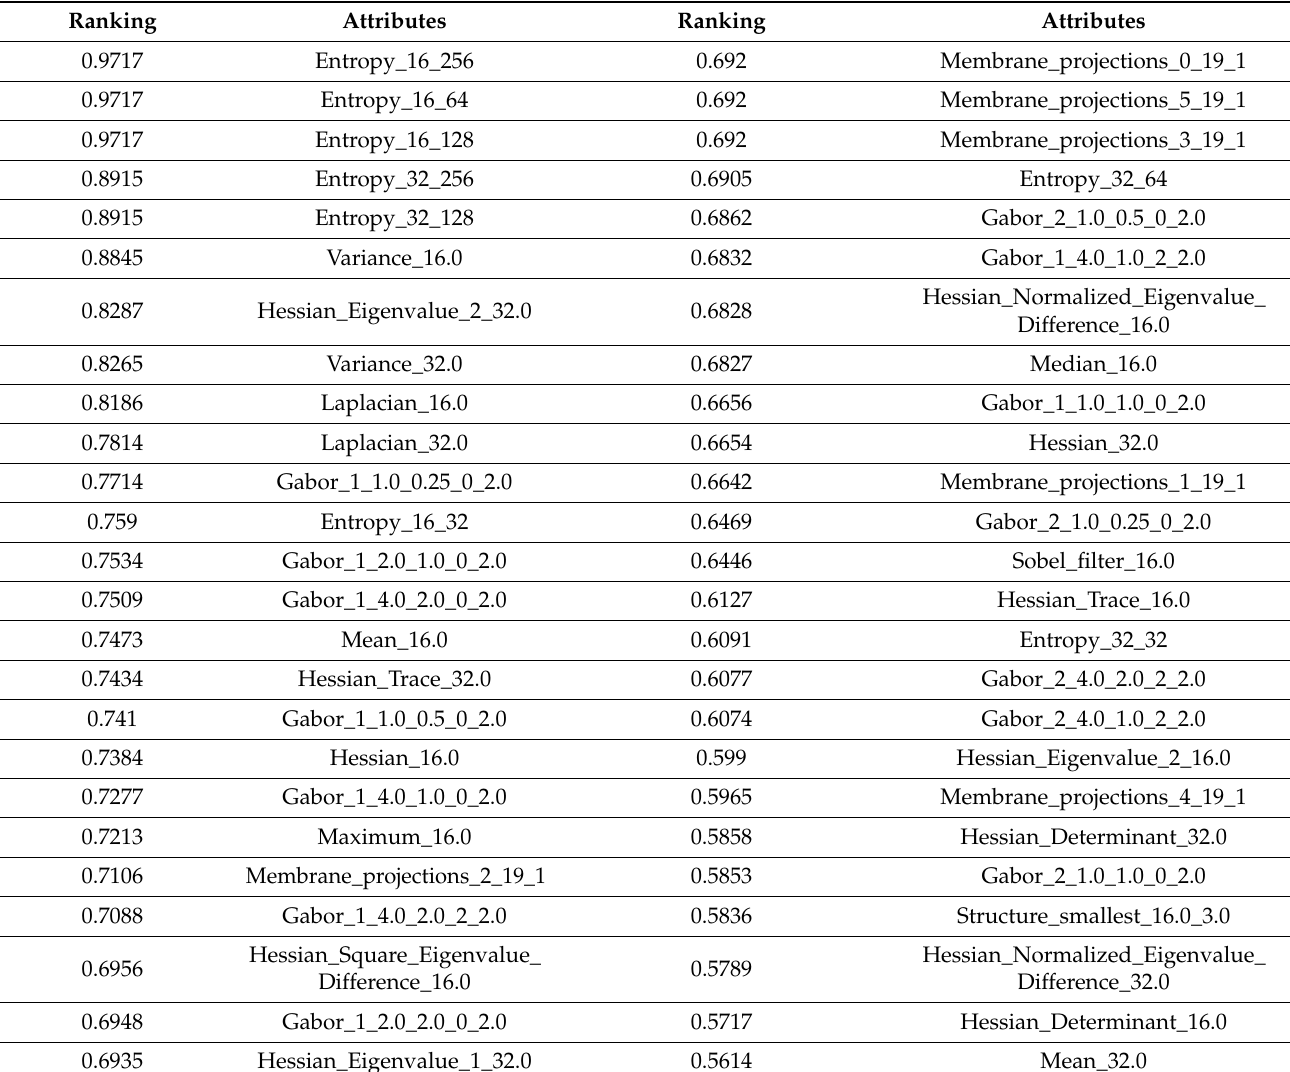
Table 1. Ranking of attributes using the InfoGainAttributeEvaluation in the WEKA